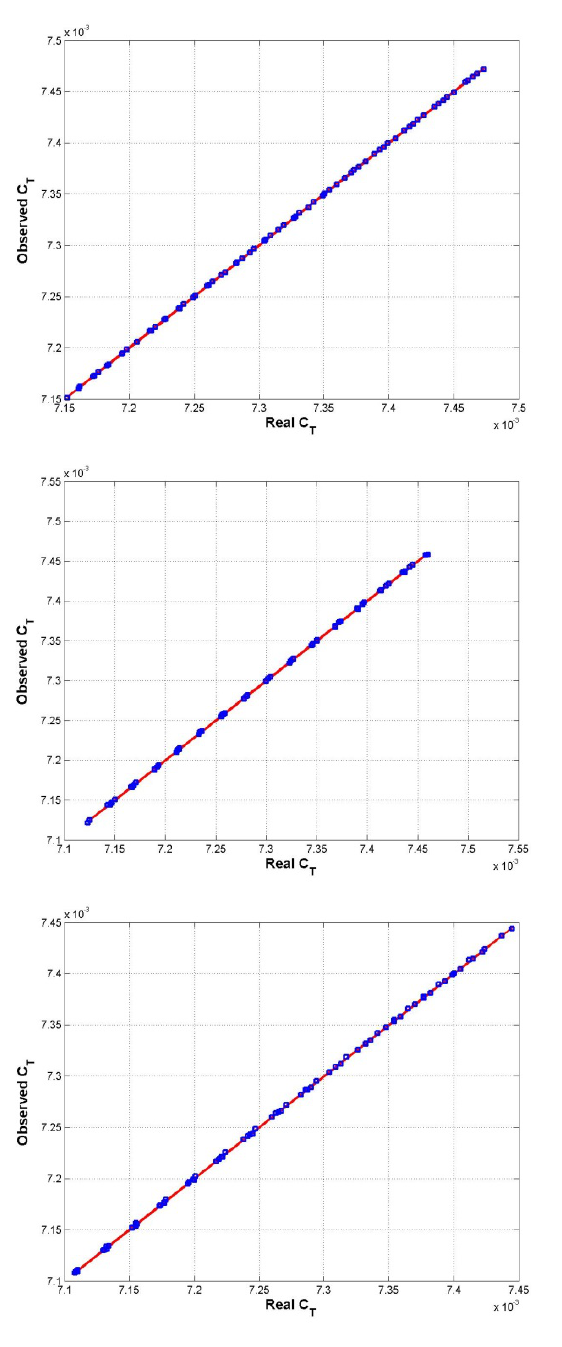
Figure 23: Model quality check for TPP-AOA (left) and thrust coeflcient (right) at 30 (top), 40 (middle), and 50 (bottom) kn airspeed. Red line: ideal correlation. Blue squares: results from sampled time